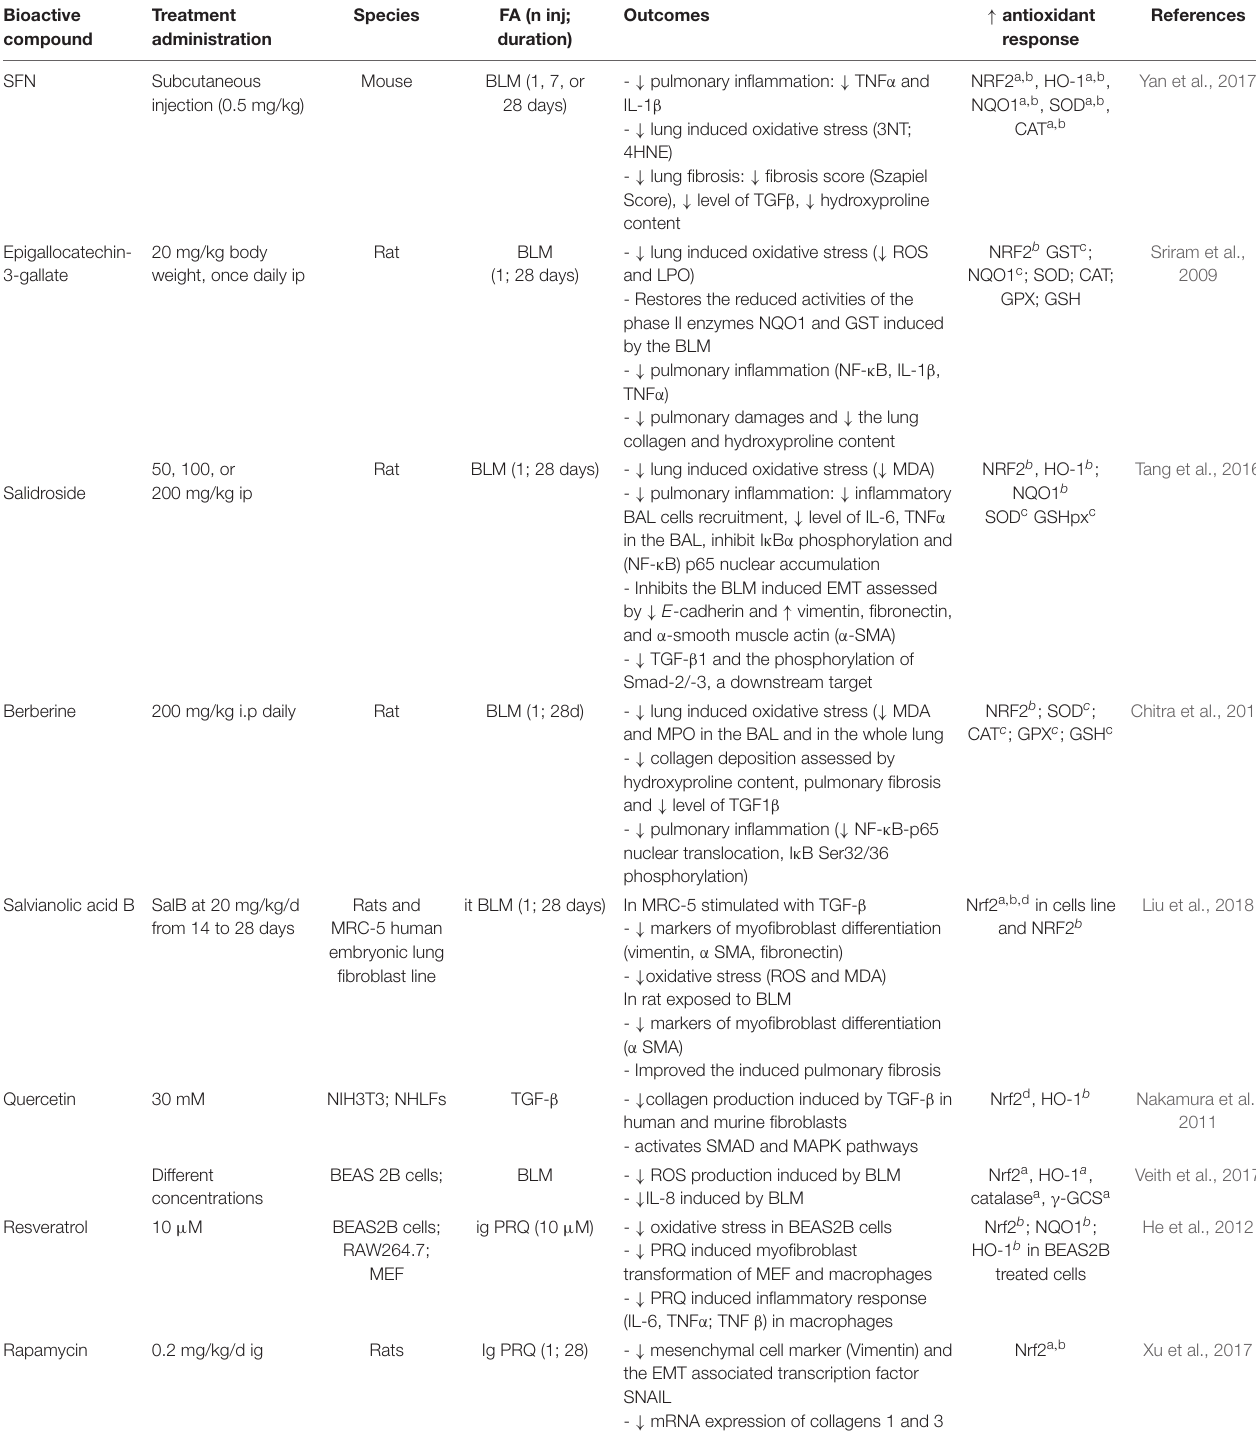
TABLE 2 | Effect of Nrf2 modulation in pulmonary